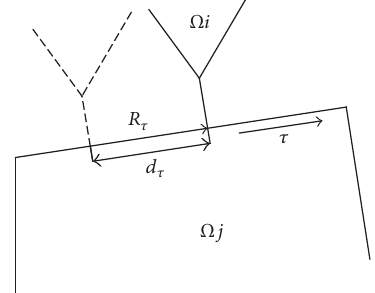
Figure 3: Model of tangential contact constraint.